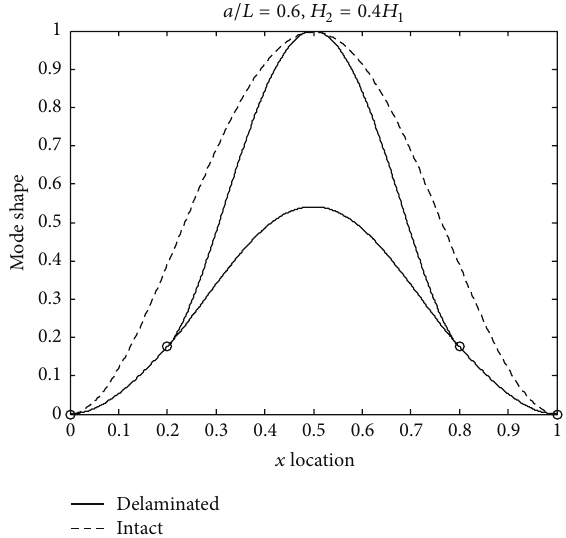
Figure 7: The first opening mode for a delaminated beam with top beam thickness equal to 40% of the height of the intact beam; 60% of span, off-midplane